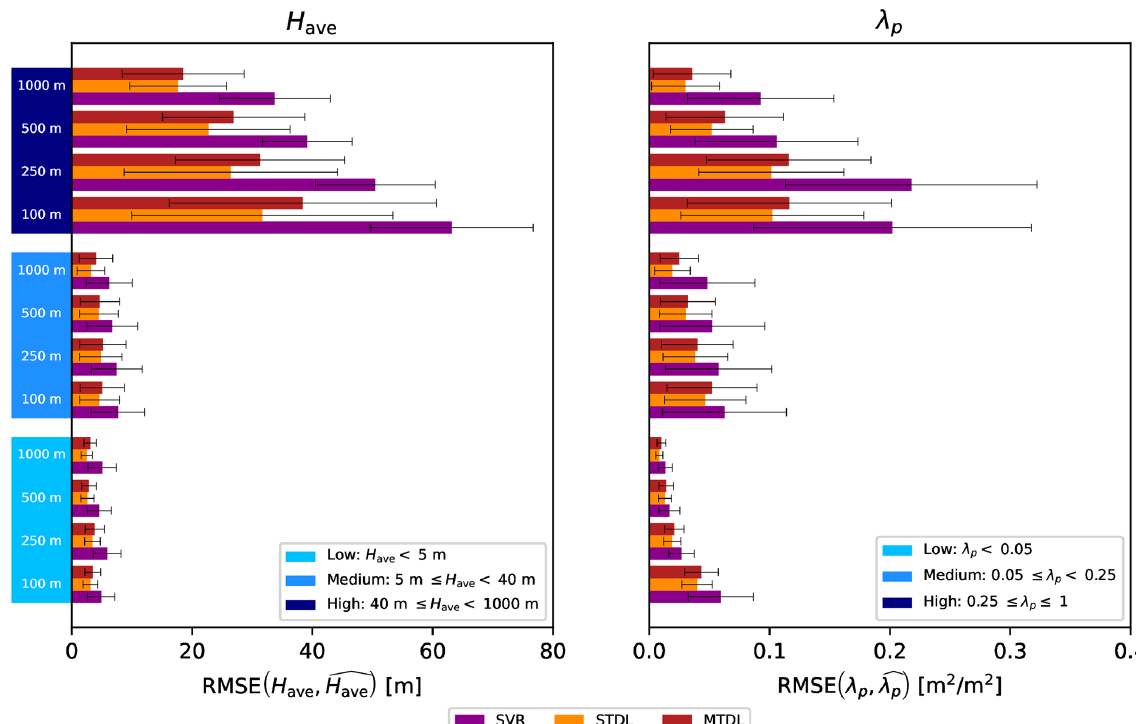
Figure 8. RMSE and NMAD of building height and footprint prediction over representative intervals where NMAD corresponds to half the length of error bars distributed symmetrically at the ends of boxes. For building height prediction, the low-value, medium-value and high-value domains are defined by H ave < 5m, 5m ≤ H ave < 40m, 40m ≤ H ave < 1000m, respectively. For building footprint prediction, the low-value, medium-value and high-value domains are defined by λ p < 0 . 05, 0 . 05 ≤ λ p < 0 . 25, 0 . 25 ≤ λ p ≤ 1, respectively.